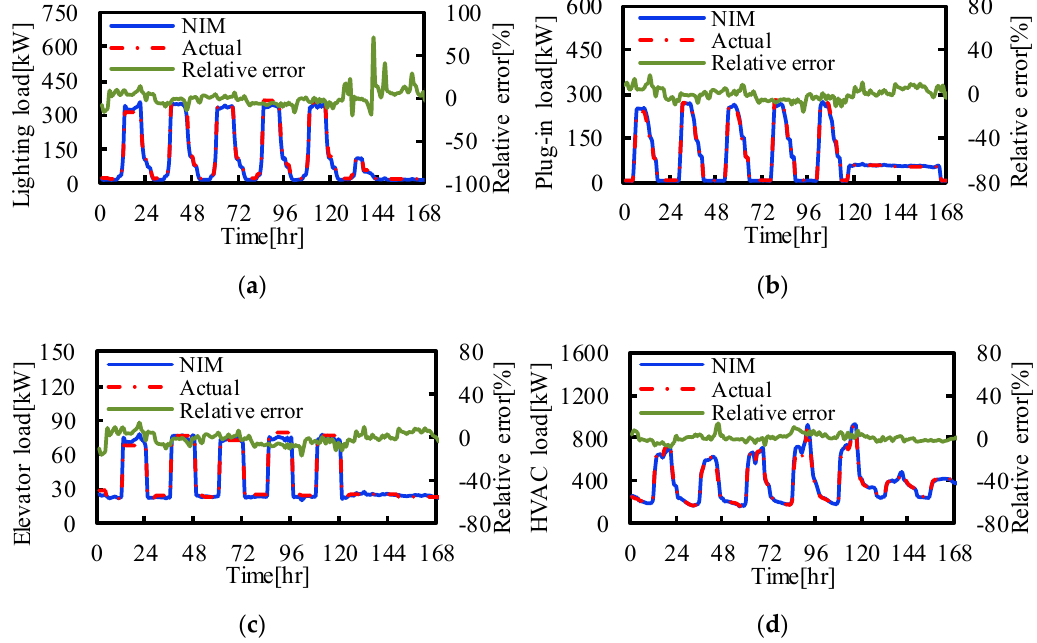
Figure 10. Testing results of the NIM model based on Approach III in a typical week: ( a ) the comparison results of lighting system load; ( b ) the comparison results of plug-in system load; ( c ) the comparison results of elevator system load; ( d ) the comparison results of HVAC system load.